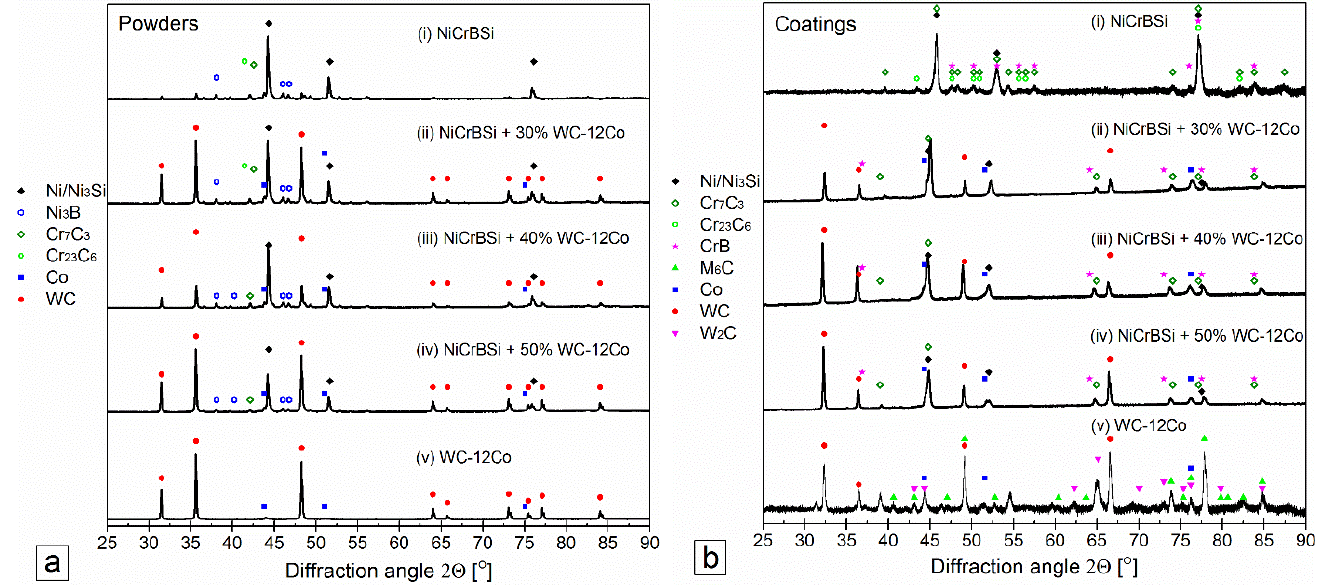
Figure 7. X-ray diffractograms for the ( a ) powders and ( b ) laser cladded coatings. The microstructures of the mixed coatings contained several additional phases. The 70% NiCrBSi/30 wt.% WC-Co consisted of a matrix phase (dark grey) that was surrounded by brighter hard phases, as shown in Figure 5b. The EDS data implied that the dark grey area of the matrix was alloyed with Co (3.4 wt.%) and W (6.2 wt.%) and formed a